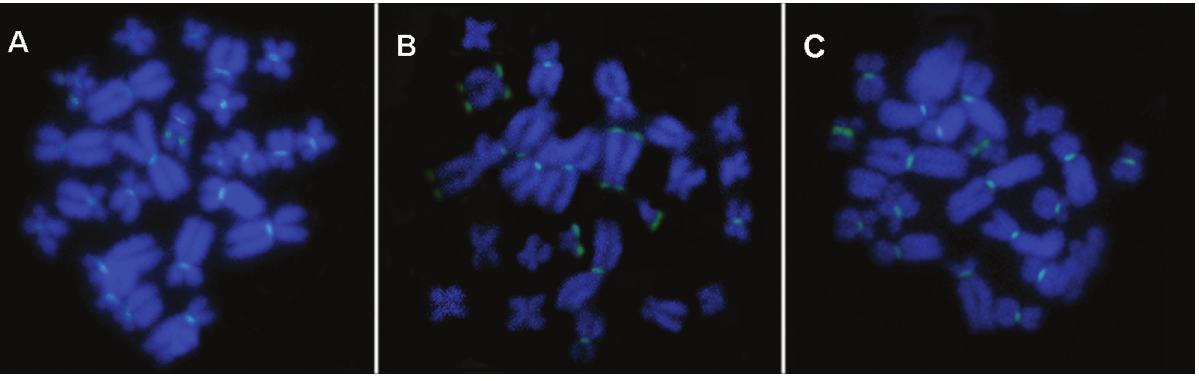
Figure 3 - Mitotic metaphases after fluorochrome staining showing CMA 3 + signals in green and chromosomes counterstained with DAPI (blue): (A) S. boesemani , (B) S. pachycrus and (C) S. x-signatus